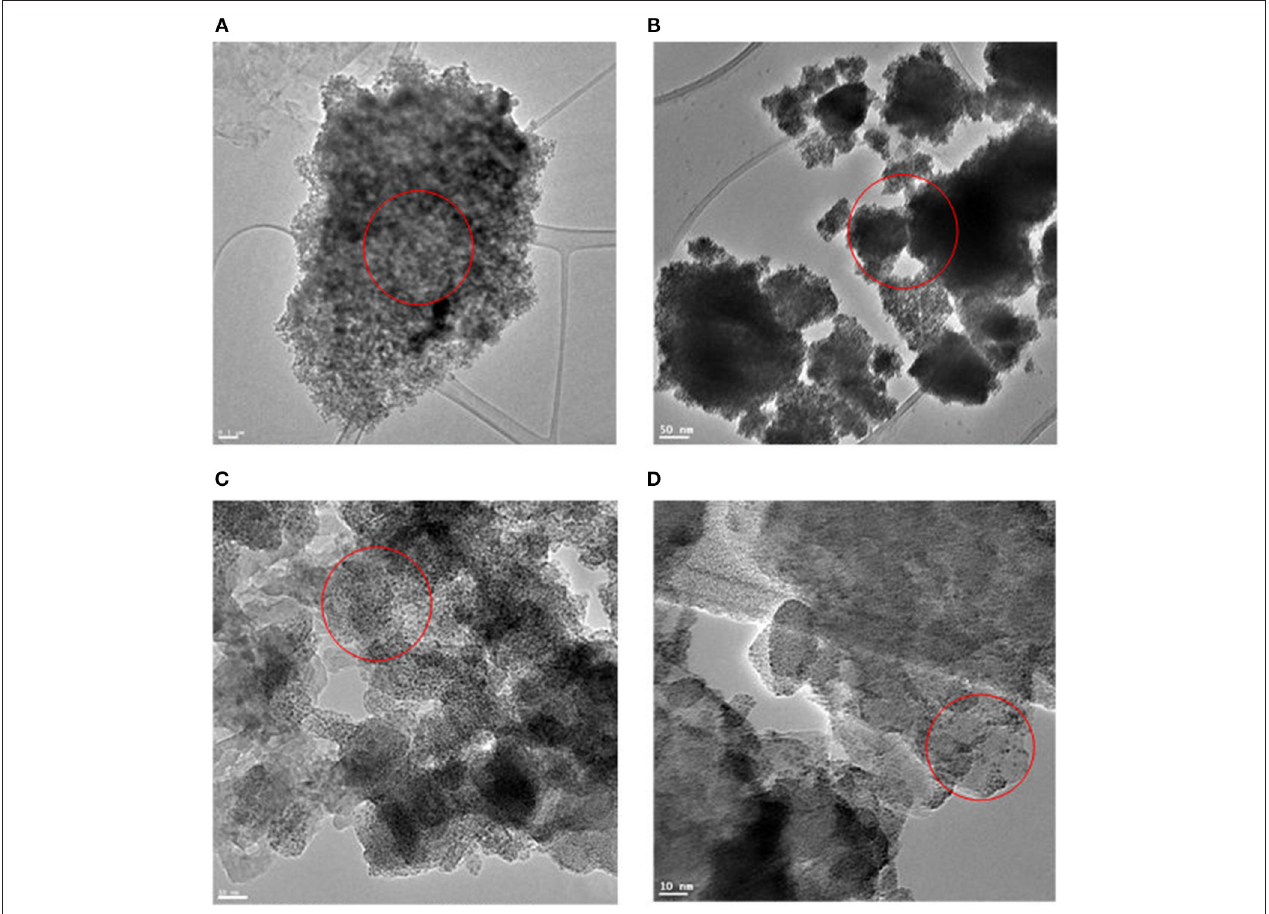
FIGURE 8 | TEM image of materials. (A) TEM image of HRO. (B) TEM image of Ru-HRO-2 (Recovered material from Table 1 , entry 13). (C) TEM image of HRO/Na- β . (D) TEM image of in situ formed Ru-HRO@Na- β -2 (Recovered material from Supplementary Table 2 , entry 2).